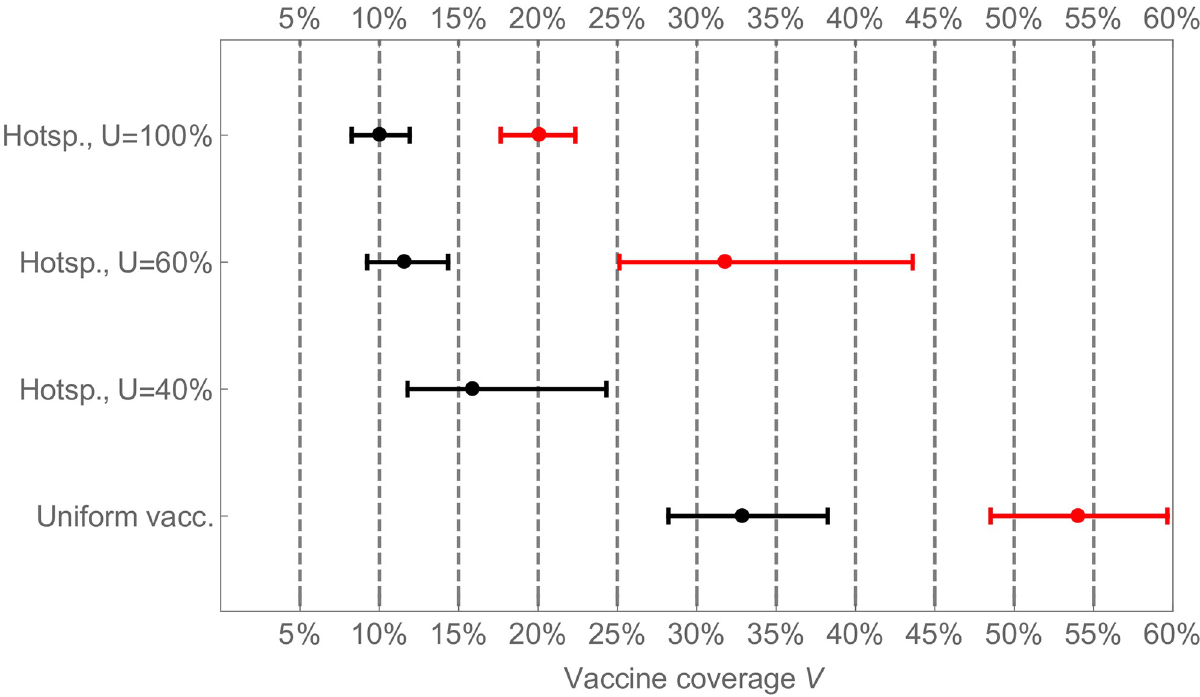
Fig 3. Necessary vaccine coverage to achieve herd immunity. The necessary vaccine coverage to bring the reproduction number from its initial value R 0 = 1.5 (black) or R 0 = 2.2 (red) to the herd immunity threshold R v = 1 is demonstrated for the uniform and hot-spotting strategy for various app usage rates. The dots represent the mean value from our simulations, whereas the intervals show the range that captures 1 σ (68.27%) of all simulation results. If R 0 = 2.2 and U = 40%, vaccinating only the app users would not be enough to reach herd